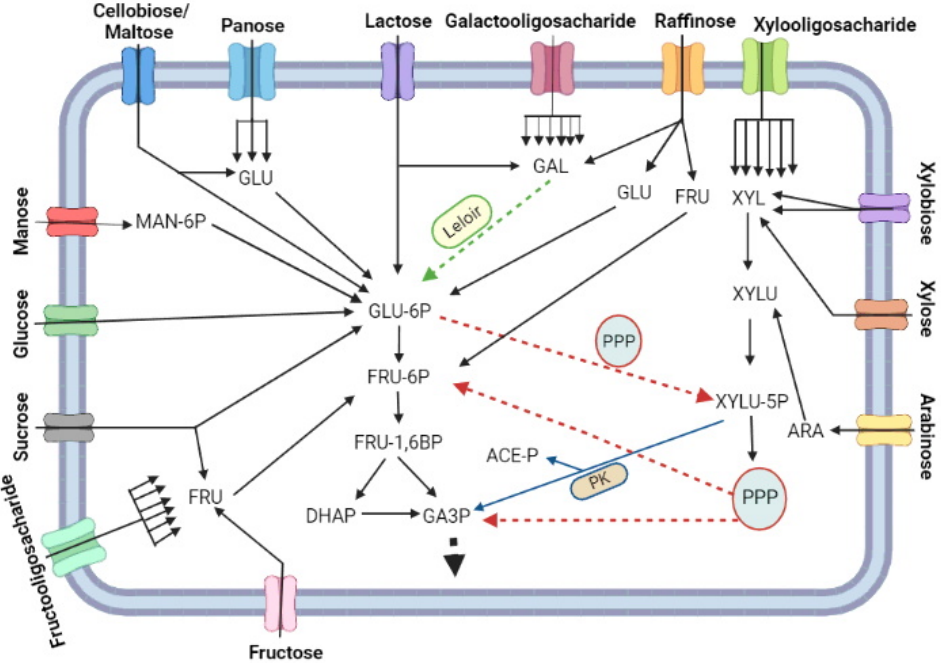
Figure 2. Overview of consumption of different types of monosaccharide sugars (glucose, fructose, galactose, mannose, arabinose and xylose), disaccharides (sucrose, lactose, maltose, cellobiose and xylobiose), trisaccharides (raffinose and panose) and oligosaccharides (fructooligosaccharide, galac- tooligosaccharide and xylooligosaccharide) and their integration into the central carbon metabolism of probiotic bacteria. Sugars composed of more than one unit must be hydrolysed during passage through transporters or by internal glycohydrolases to release the constituent monosaccharides. Hexoses are converted to glucose 6-phosphate (GLU-6P) or fructose 6-phosphate (FRU-6P). The exception is galactose, which initially must be metabolized by the Leloir pathway. Next, GLU-6P and FRU-6P are metabolized via the glycolytic pathway. GLU-6P can also be metabolized via the pentose phosphate pathway (PPP) to subsequently return to the glycolytic pathway. Pentoses, in turn, are converted directly by PPP. The intermediate xylulose 5-phosphate (XYLU-5P) from GLU-6P or pentoses can be broken down into a molecule of glyceraldehyde 3-phosphate (GA3P) and a molecule of acetyl phosphate (ACE-P) by the enzyme phosphoketolase (PK). Despite its origins, Glu-6P is further isomerized to Fructose-6P (Fru-6P), phosphory- lated to fructose-1,6 biphosphate (Fru-1,6P) and breakdown into two triose phosphates: glyceraldehyde 3-phosphate (G3P) and dihydroxycetone 3-phosphate (DHAP). Each mol of DHAP is isomerised to G3P and both G3P molecules follows the oxidative part of gly- colysis for the final production of 2 mols of pyruvate, 2 mols of NADH and 2 mols of ATP. Alternatively, Glu-6P goes to the Pentose Phosphate Pathway (PPP) through its oxidation to phosphogluconate and ultimately by decarboxylation to ribulose-5 phosphate (Ribu- 5P), with the production of two reducing equivalent in the form of NADPH [94,96]. Then, part of Ribu-5P is isomerised to ribose 5-P (Rib-5P) and part is epimerised to xylulose-5 phosphate (Xylu-5P). A small fraction of Rib-5p is deviated for nucleotide biosynthesis while the majority of Rib-5P molecules condensates with xylu-5P for a series of transaldolase and transketolase reactions in the PPP [96–98]. At the end, this pathway provides Fru-6P and G3P, which return to glycolysis (Figure 2), and erythrose-4P (Ert-4P) used for amino acid biosynthesis